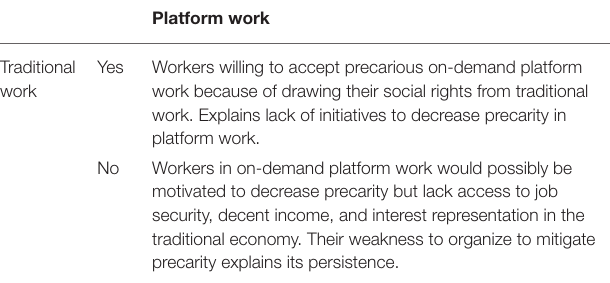
TABLE 2 | Coexistence between traditional and platform work as a factor in explaining precarity. Platform